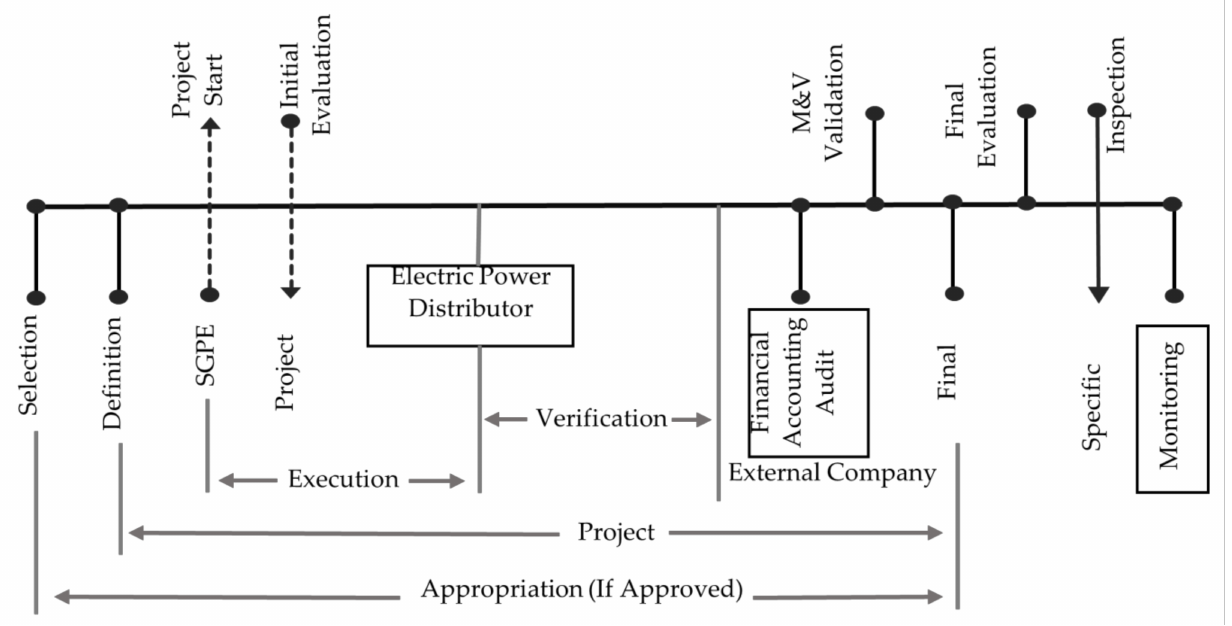
Figure 2. Stages of EEPROJ (Energy Efficiency